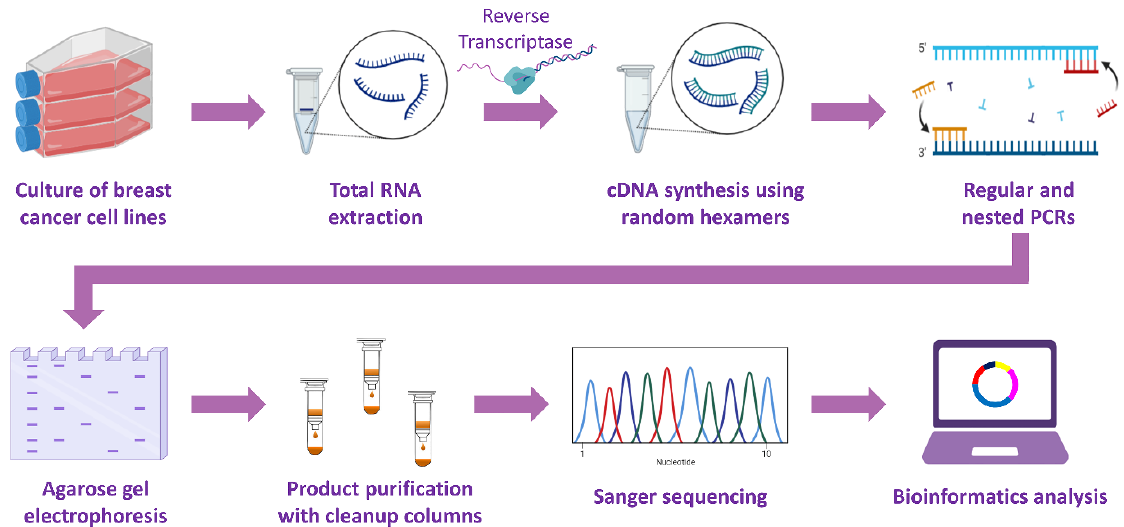
Figure 1. Overview of the experimental workflow that was followed in this research article for the identification of novel PRMT1 circRNAs in breast cancer cell lines. identification of novel PRMT1 circRNAs in breast cancer cell